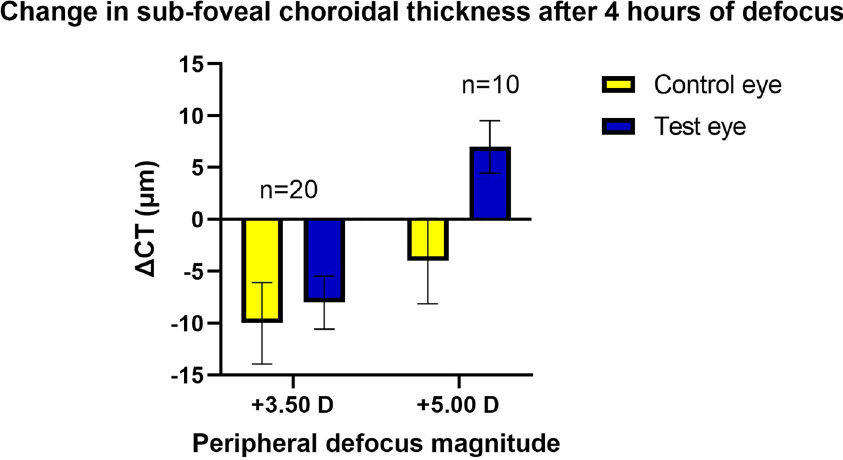
Figure 3. Sub-foveal choroidal thickness changes (mean ± SEM) following 4 h of peripheral defocus